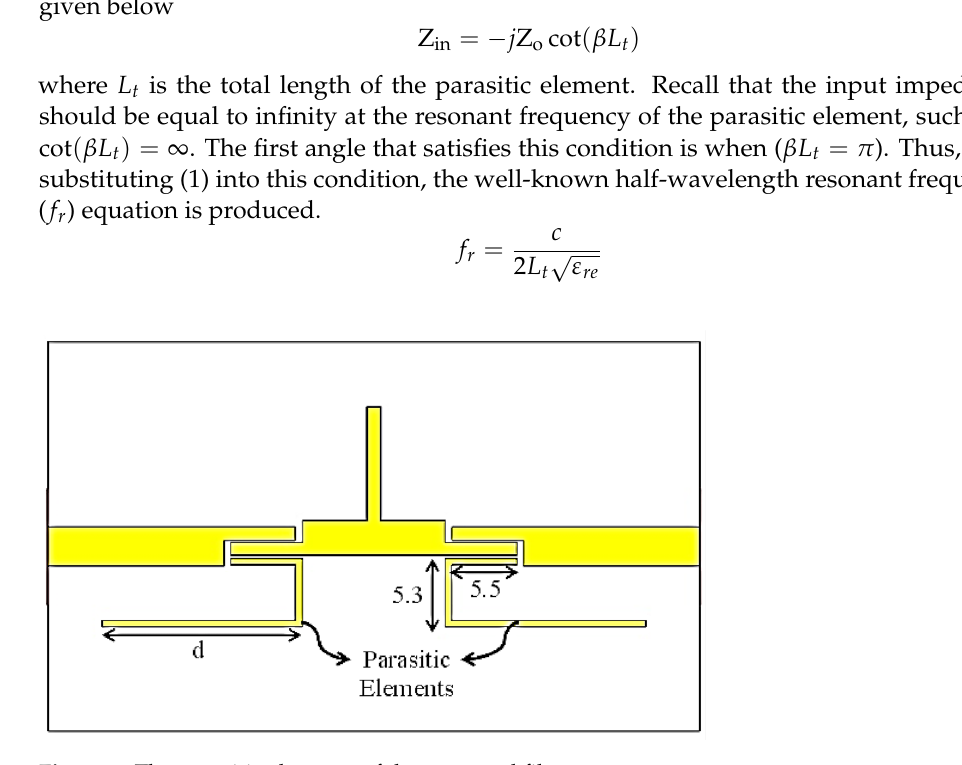
Figure 5. The parasitic elements of the proposed filter. The above equation is tested and analyzed in most of the researches related to the band notch generation [44]. Consequently, the test of the accuracy of this equation holds only the optimum value which is obtained when the parasitic element arm ( d ) is equal to (51.4 mm). The overall length under this condition is found to be (26.2 mm). For this total parasitic element length, the mathematically estimated transmission zero is located at (3.18 GHz), while for the CST Microwave Studio value is (3.24 GHz). The current distribution of the proposed BPF outside the transmission zero (f = 3.9 GHz) and inside it (f = 3.24 GHz) is illustrated in Figure 6. It is clear that the current is concentrated around the parasitic element at the transmission zero frequency f = 3.24 GHz, and there is a very negligible amount of current that reaches the output port (right-hand port in Figure 6a). On the other hand, the output port (right-hand port) in Figure 6b has a significant amount of current that verifies the successful energy transmission outside the transmission